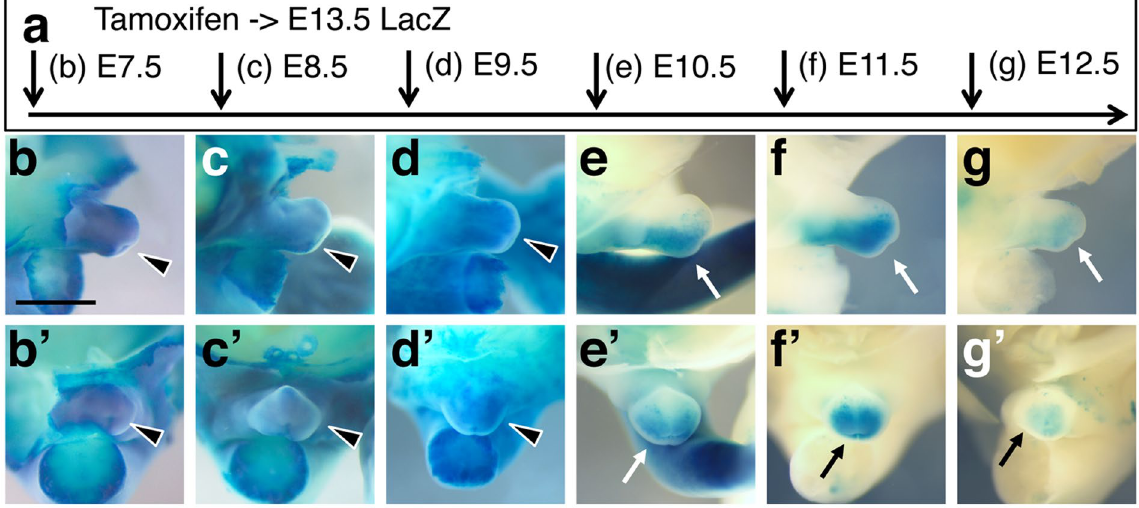
Figure 4. Sall4 lineage contribution to the external genital primordium. Schematic of tamoxifen injections at different time points of embryonic development. ( b –g’) Lateral views ( b – g ) and frontal views (b’–g’) of external genitalia of LacZ stained E13.5 embryos. Black arrowheads point to the broadly stained external genitalia, labelled at E7.5–E9.5. Arrows point to the LacZ-stained posterior of external genitalia, labeled at E10.5–12.5. Scale bar in panel b: 1 mm. Panels b to g’ are in the same